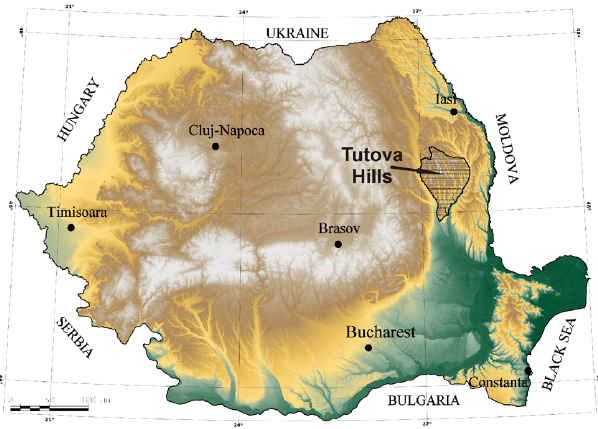
Fig. 1. Location of the study area: Tutova Hills (Eastern